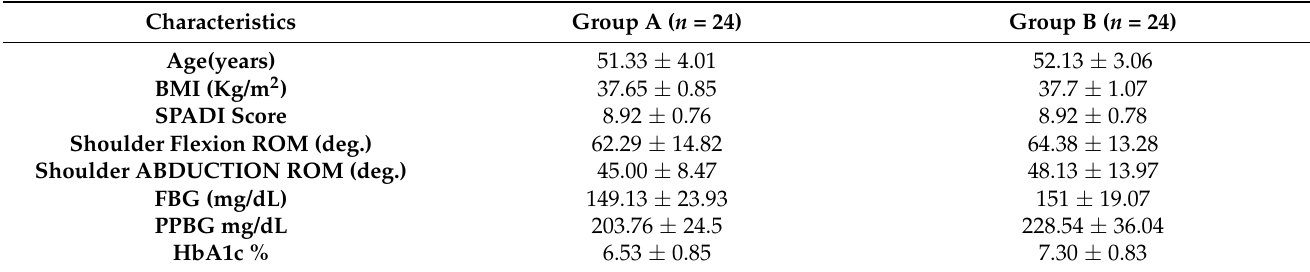
Table 2. Basal Characteristics of The Subjects of the study